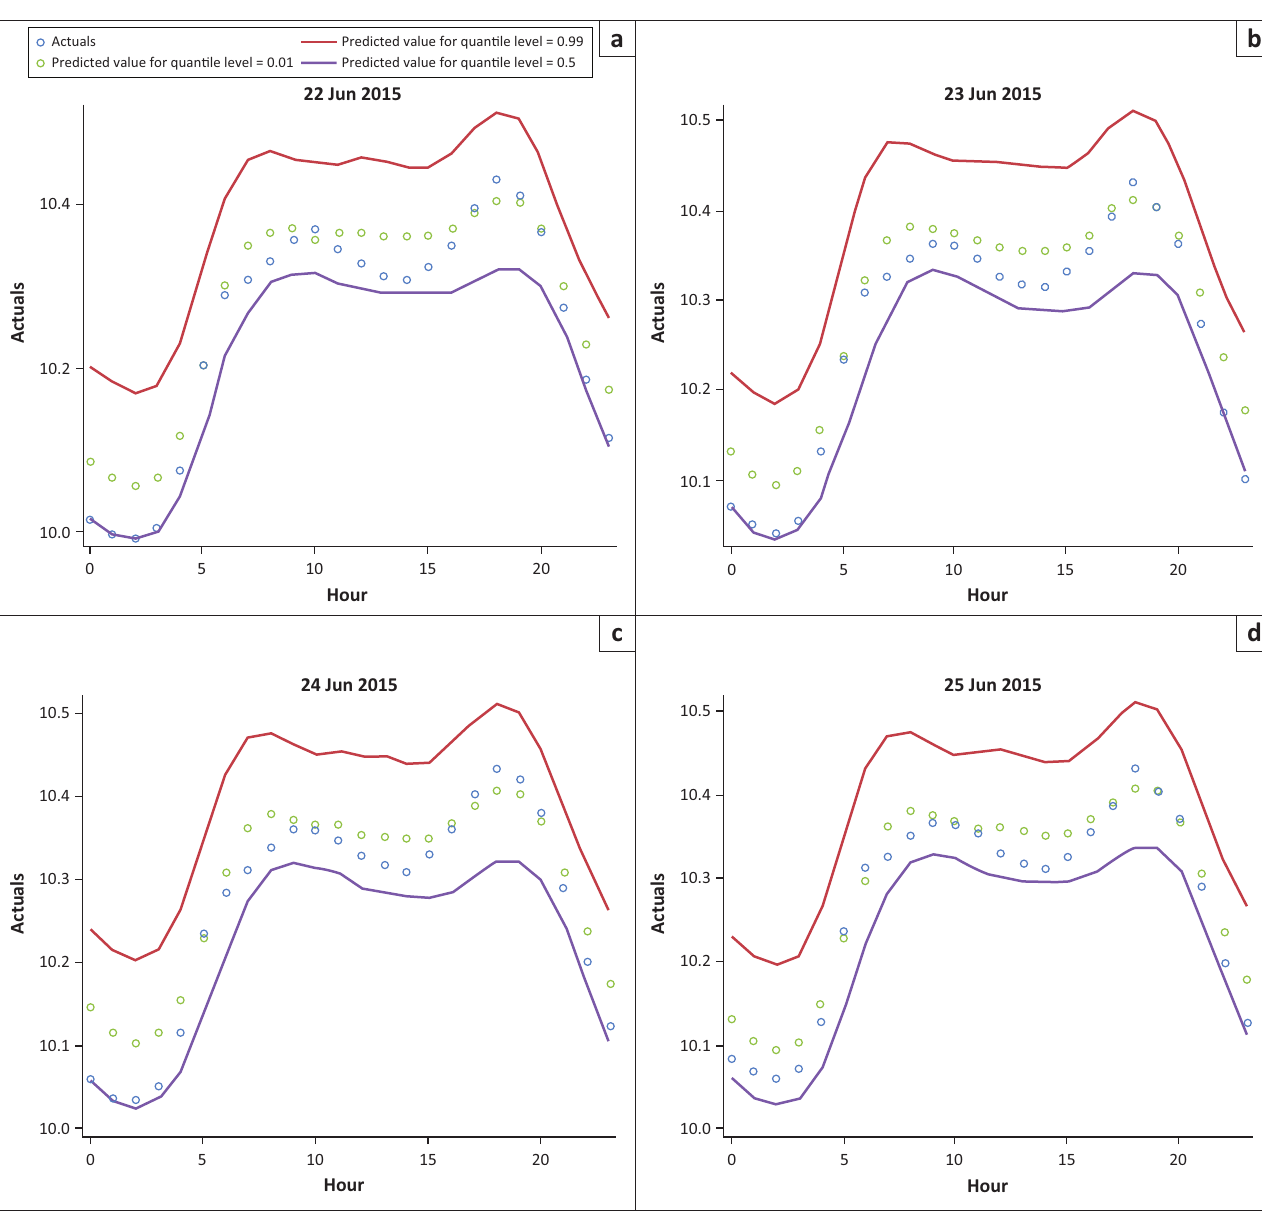
FIGURE 6: Distribution of forecasted daily electricity demand: (a) 22 June 2015, (b) 23 June 2015, (c) 24 June 2015, (d) 25 June 2015.